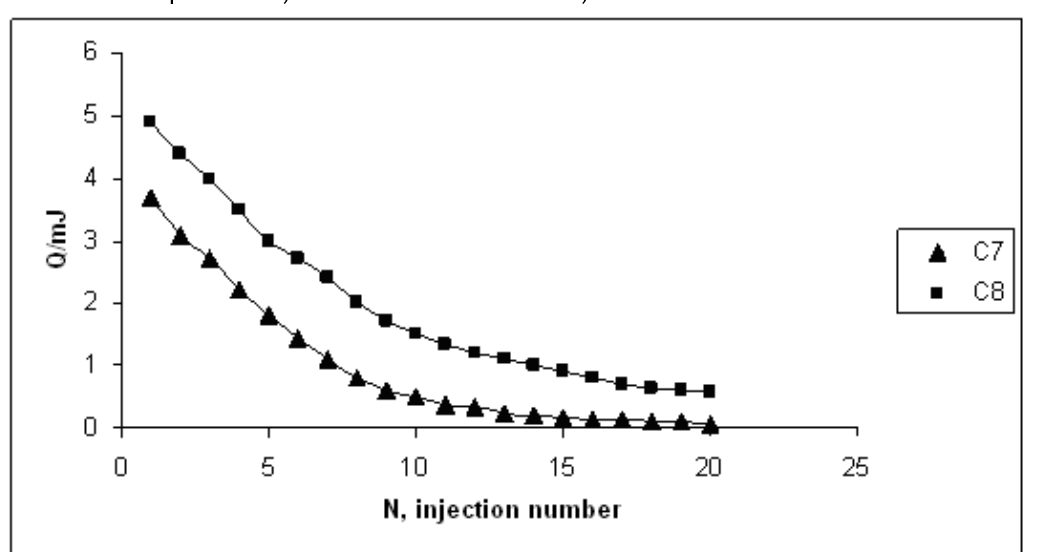
Figure 4. Heat evolution per injection, Q, plotted against injection number, N. The fitted lines for: ▲ heptan-1-ol, ■ octan-1-ol. ————, fitted